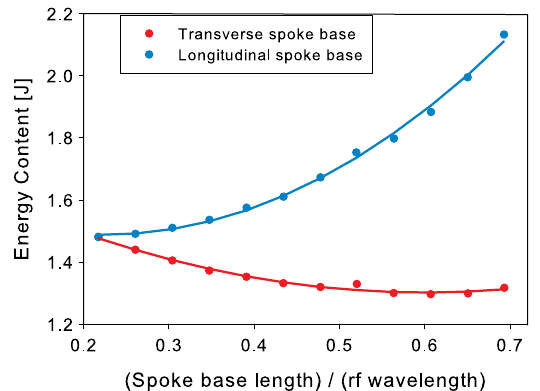
FIG. 6. Dependence of energy content on spoke base length for longitudinal and transverse orientations at a constant accelerat- ing field of 1 MV = m . The leftmost point is common to both curves since it represents a cylindrical spoke base.